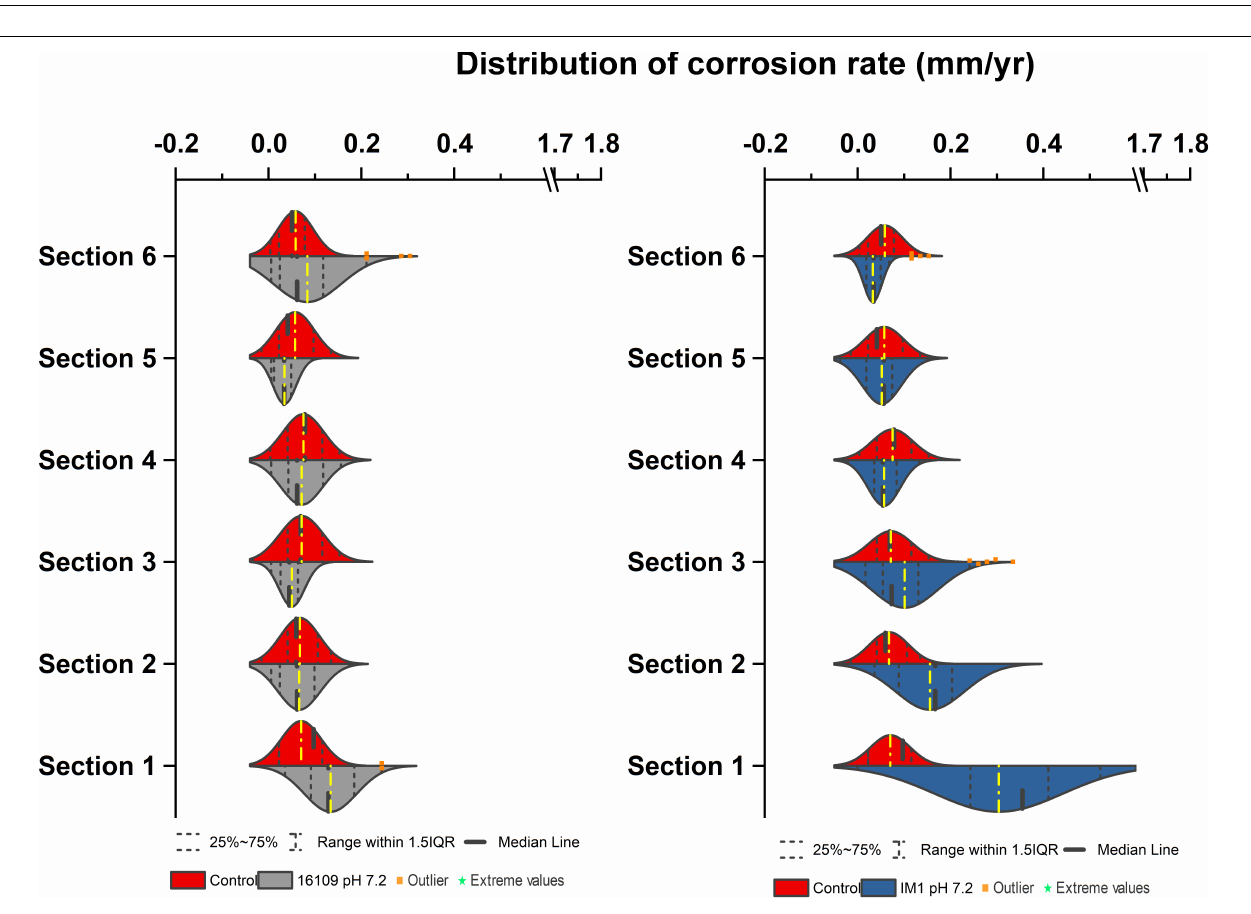
FIGURE 6 | IM1-treated carbon steel beads extracted from the column post-experiment. Beads with 0.52 mm/yr corrosion rate (B,C) and 0.38 mm/yr corrosion rate (D,E) are shown in comparison to the control bead with no corrosion (A) .